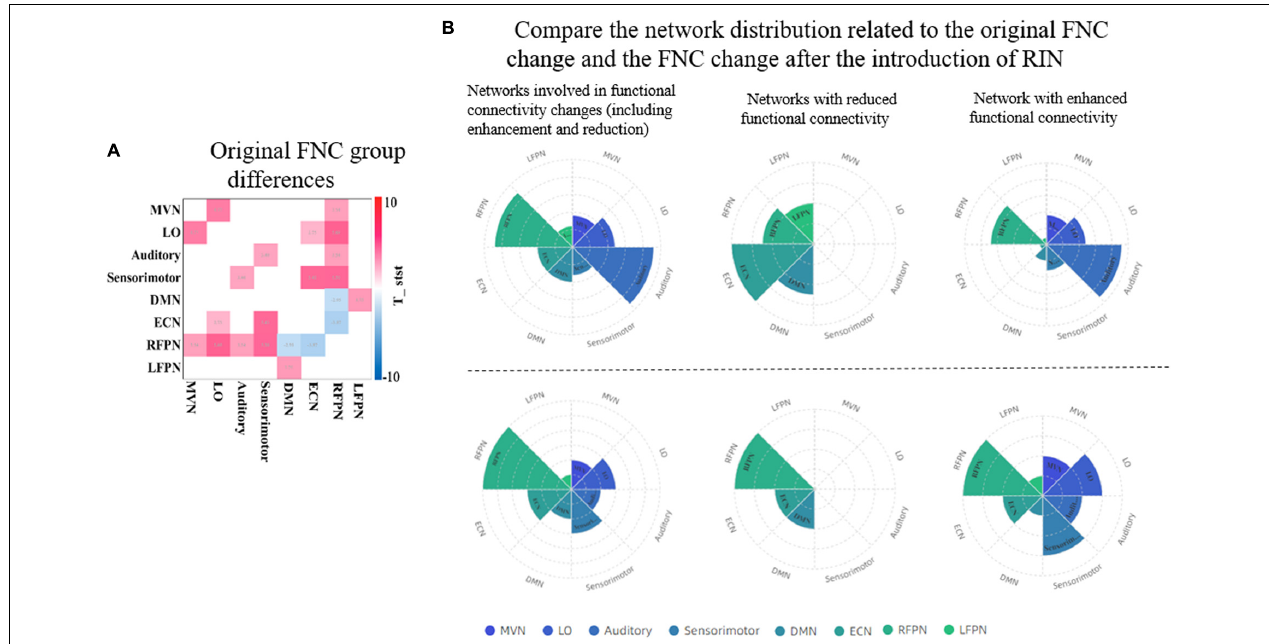
FIGURE 10 | Comparison of the ability of the original network and RINs to detect abnormalities in ADHD patients. (A) The group differences of the original FNC. A two-sample t -test was used to detect differences between HCs and ADHD patients. Only functional connections with significant differences are shown in the graph ( p < 0.05, FDR corrected). Red color indicates enhanced functional connectivity in ADHD patients, and blue color indicates weakened functional connectivity. (B) The distribution of the networks involved in the FNC group differences detected by the two approaches. The bottom three plots show the FNC change statistics for the original network, and the top three plots show the functional connectivity change statistics after the introduction of RINs. In the top plots, the statistics for each network include the corresponding RIN and AN. For two the left plots, the overall change includes the increase and decrease of functional connectivity; the middle two plots are the networks with weakened functional connectivity; and the two right plots are the networks with enhanced functional connectivity. RIN, relatively inert network; ADHD, attention deficit hyperactivity disorder; FNC, functional network connectivity; HC, healthy control; FDR, false discovery